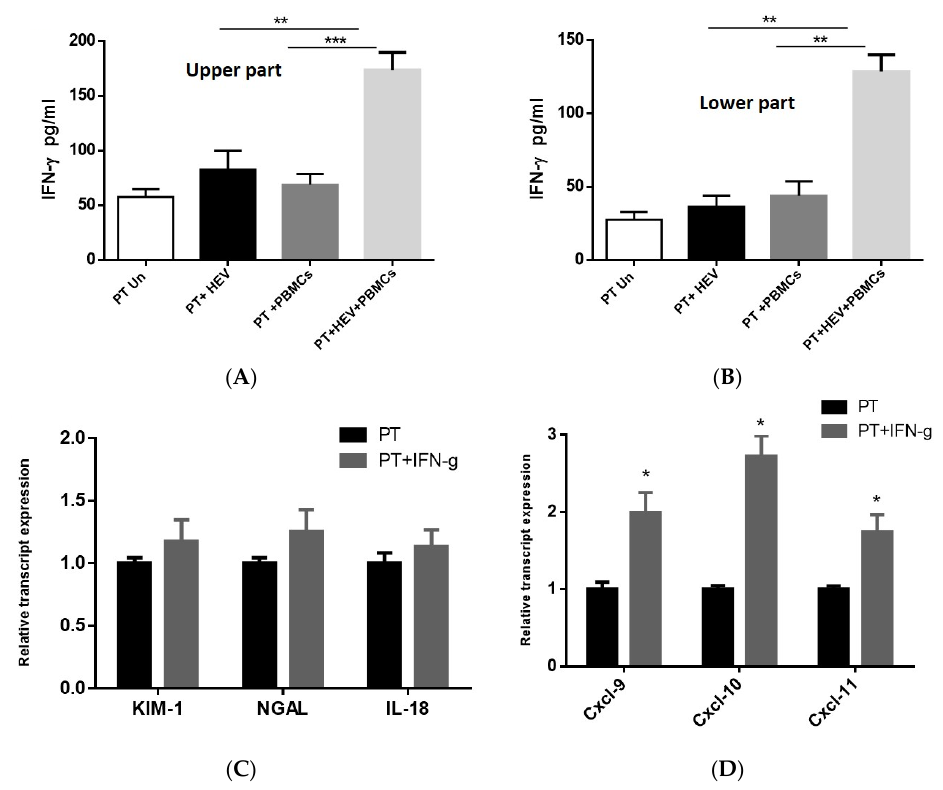
Figure 5. Exacerbation of the inflammatory response was dependable on IFN-γ produced from the PBMCs. PT cells, either uninfected or HEV-infected in the presence or absence of coculture with PBMCs, were assessed for IFN-γ. The level of IFN-γ was measured in the apical (upper compartment) ( A ) and basolateral (lower compartment) ( B ) of PT cells, PT cells cocultured with PBMCs challenged or not with HEV. PT cells were treated or not with IFN-γ (1 ng/mL) for 3 days. The relative expression levels of kidney injury markers (KIM-1, NGAL, and IL-18) ( C ) and chemokines ( D ) was compared in PT cells treated (gray) or not (black) with IFN-γ. Data represent the mean ± SEM of four separate experiments. *, **, and *** indicates p ≤ 0.05, p ≤ 0.01, and p ≤ 0.001 as assayed by two-tailed Student’s t